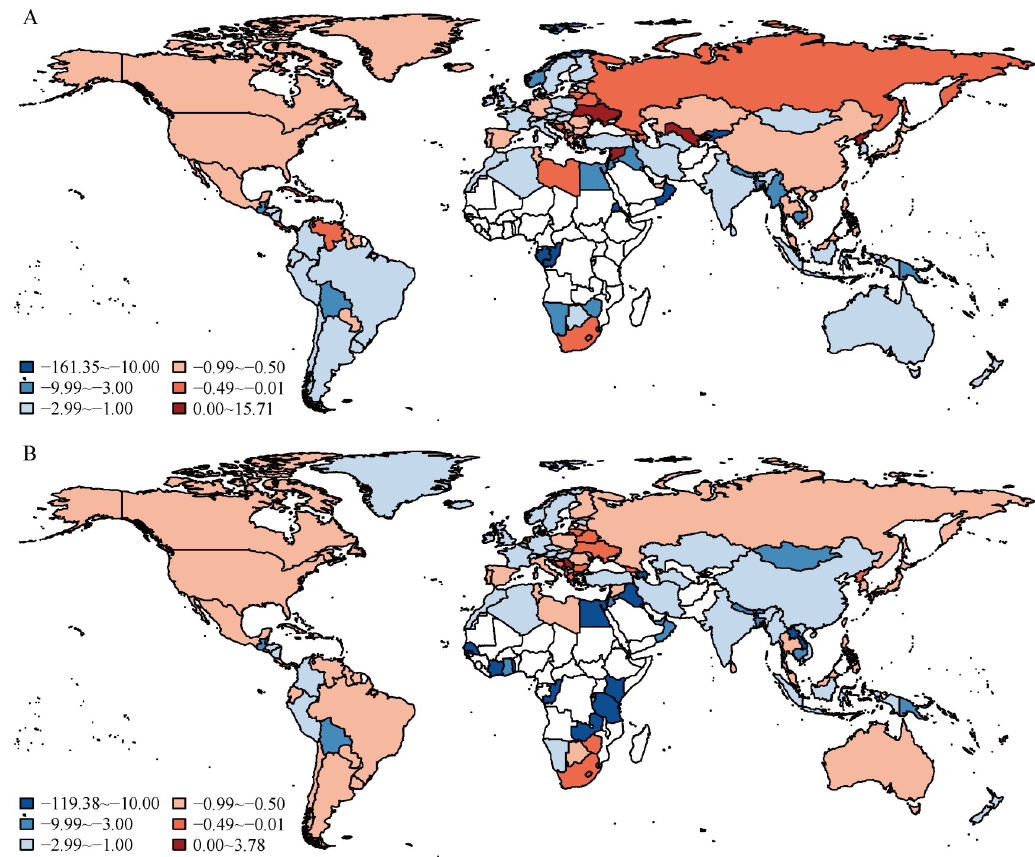
Fig 4. Ratio between total deaths attributed to change in mortality rate and total deaths associated with population ageing between 1990 and 2017. (A) Male; (B) female. The ratio was calculated as the change in total deaths attributed to change in mortality rate divided by that associated with population ageing. Blue signifies countries and territories for which the decrease in total deaths attributed to changes in mortality was more than the increase attributed to population ageing between 1990 and 2017. Red signifies countries and territories for which the decrease in total deaths attributed to changes in mortality was less than the increase associated with population ageing between 1990 and 2017. White signifies countries and territories not experiencing an increase in deaths associated with population ageing between 1990 and 2017. The maps were drawn using the R package “maps,” which was based on the data from the Natural Earth project.